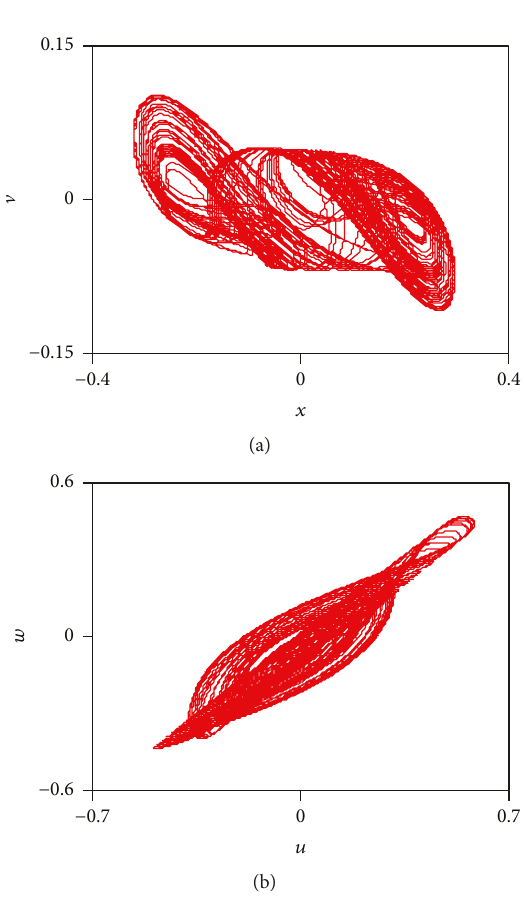
Figure 4: Chaotic attractor of the circuit with three memristors (a) x - v (b) u - w